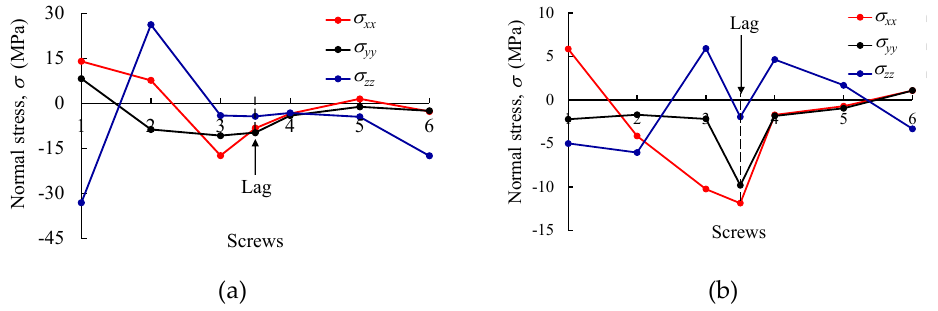
Figure 16. Normal stress in bone regions S1S6 (and Lag) sited ( a ) in contact with the metal plate and ( b ) on the opposite side of the bone shaft.